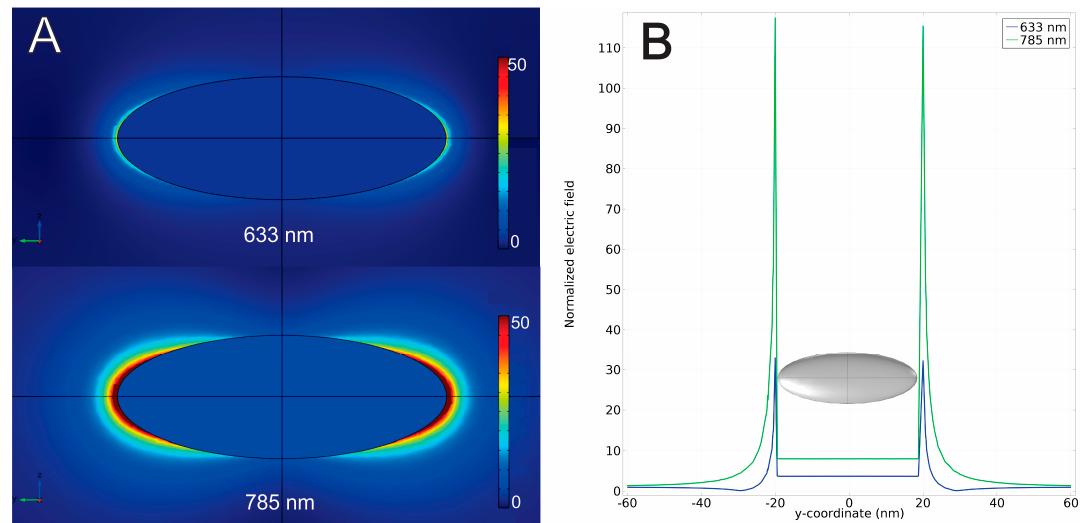
Figure 2. Local electric field enhancement ( A ) in the vicinity of one AgNP for incident radiation at 633 nm ( A , top scheme) and at 785 nm ( A , bottom scheme). Graphical representation of the electric field strength ( B ) (normalized to the incident field) along the y -axis of the simulation crossing the points of greater electric field intensity around the apexes of the AgNP.